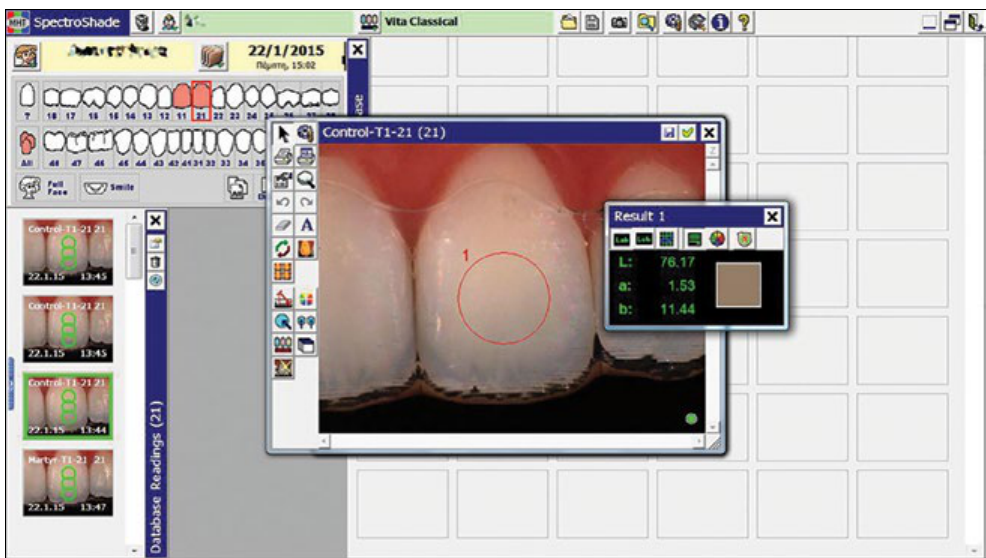
Figure 1. Spectrophotometric analysis of the labial surface of an incisor with a retainer on with the SpectroShade™